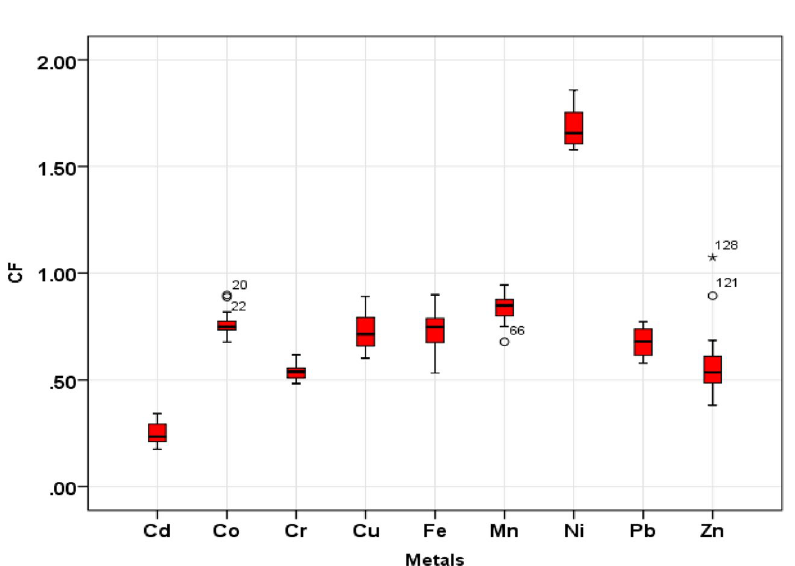
Figure 3. Box plots of CF values for TEs in the soils of